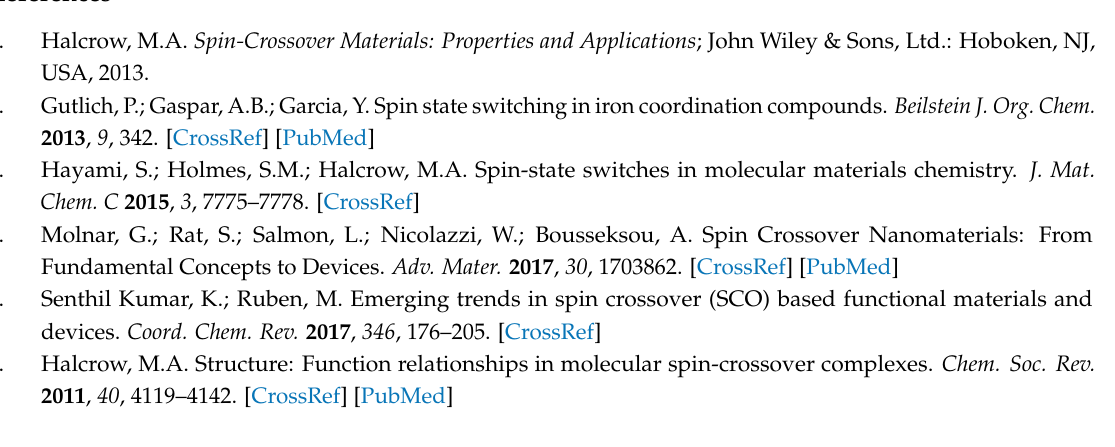
46/s1, Table S1: Crystal data and structure refinement parameters for the studied complexes, Figure S1: Variable-temperature magnetic susceptibility data for microcrystalline samples of Fe( L2 ) 2 OTf 2 and Fe( L2 ) 2 (BF 4 ) 2 according to dc -magnetometry and for their acetonitrile-d 3 solutions according to the Evans method, Figure S2: 1 H chemical shifts for an acetonitrile-d 3 solution of Fe( L2 ) 2 OTf 2 and Fe( L2 ) 2 (BF 4 ) 2 plotted versus 1/T , Figures S3 and S4: Correlation plot of experimental vs. theoretical 1 H chemical shifts for Fe( L2 ) 2 OTf 2 and Fe( L2 ) 2 (BF 4 ) 2 , Figures S5 and S6: Packing of [ML 2 ] 2+ cations in Fe( L1 ) 2 OTf 2 , Zn( L1 ) 2 (ClO 4 ) 2 , Fe( L2 ) 2 OTf 2 and Fe( L2 ) 2 (BF 4 ) 2 Figure S7: Organic compounds with a phenyl-pyrazol-1-yl or phenyl-pyrazol-3-yl fragment distributed over the angle between the two planes, Figure S8: 1 H NMR spectra of the ligand L1 and the complex Zn( L1 ) 2 (ClO 4 ) 2 , Figure S9: Differences in 1 H chemical shifts between the complex Zn( L1 ) 2 (ClO 4 ) 2 and the ligand L1 , Figure S10: ROESY NMR data for Zn( L1 ) 2 (ClO 4 ) 2 , Figure S11: General view of the HS complexes [Fe(L) 2 ] 2+ of terpy and bpp with phenyl groups (and similar) from CSD showing ‘parallel-displaced’ intramolecular stacking interactions, Figure S12: 1 H NMR spectra recorded after adding equimolar quantities of L1 , terpy and FeCl 2 in